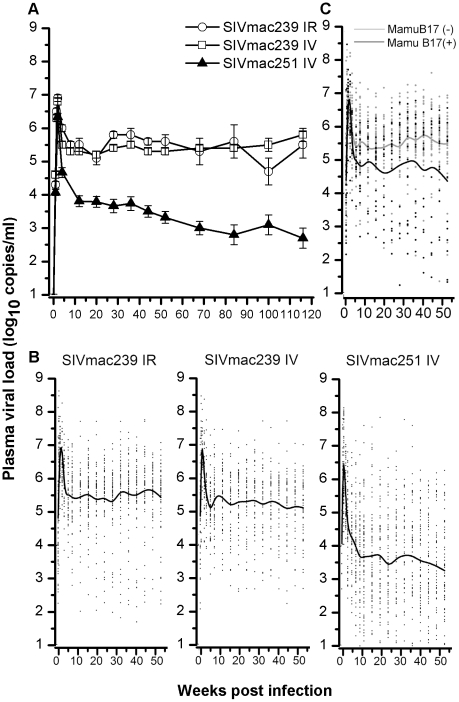
Plasma SIV RNA viral loads in Ch RhMs randomly challenged with pathogenic SIVmac239 (ir or iv) or SIVmac251 (iv).(A) Evolution of plasma SIV RNA viral loads (geometric mean ± SE) following 118 weeks post viral challenge. (B) Smoothed curve of the SIV RNA levels in plasma of animals following 52 weeks post viral challenge with SIVmac239 (ir or iv) or SIVmac251 (iv). (C) Smoothed curve of the SIV RNA levels in plasma of SIVmac239-infected Ch RhMs with or without MHC-I B17 allele.